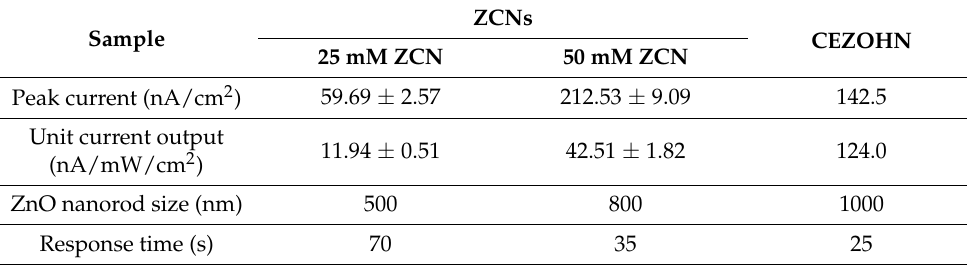
Figure 11. Current output comparison of ZCNs and CEZOHN: ( a ) peak current outputs with UV intensity changing and ( b ) the maximum unit current output with the ZnO nanorods’ length. Table 2. Photosensitivities of the ZCNs compared with